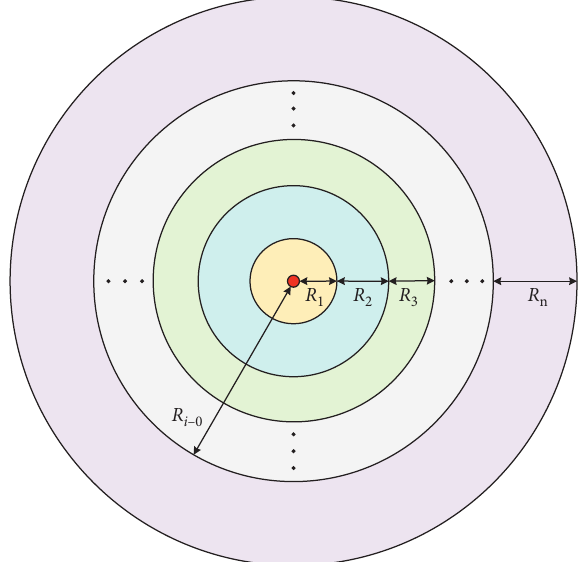
Figure 1: Initial distribution of CH election areas ( z � 4).